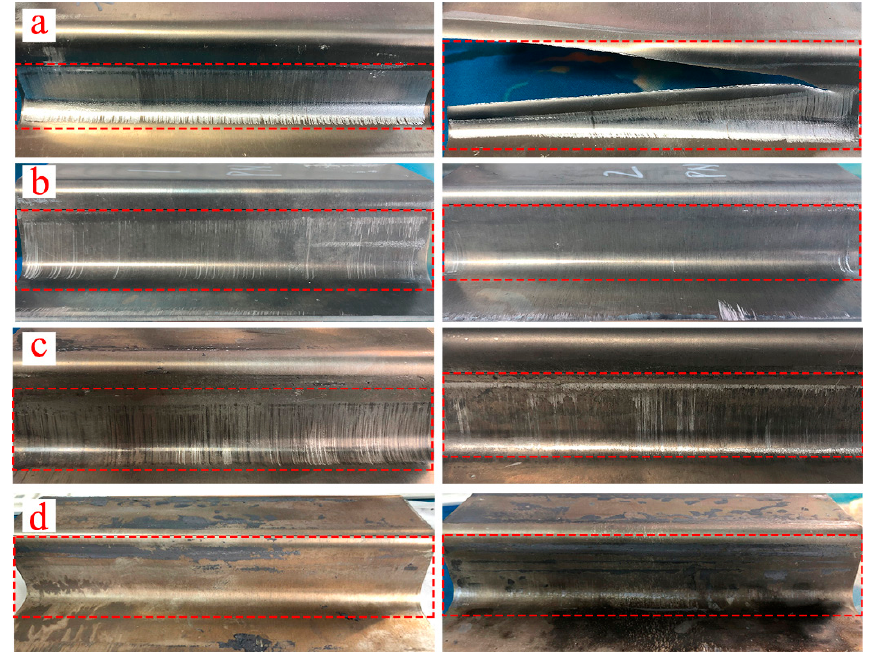
Figure 8. U-shaped parts of different lubrication conditions: ( a ) No lubricant; ( b ) Boron nitride lub- ricant; ( c ) Graphite lubricant; ( d ) Molybdenum disulfide lubricant.